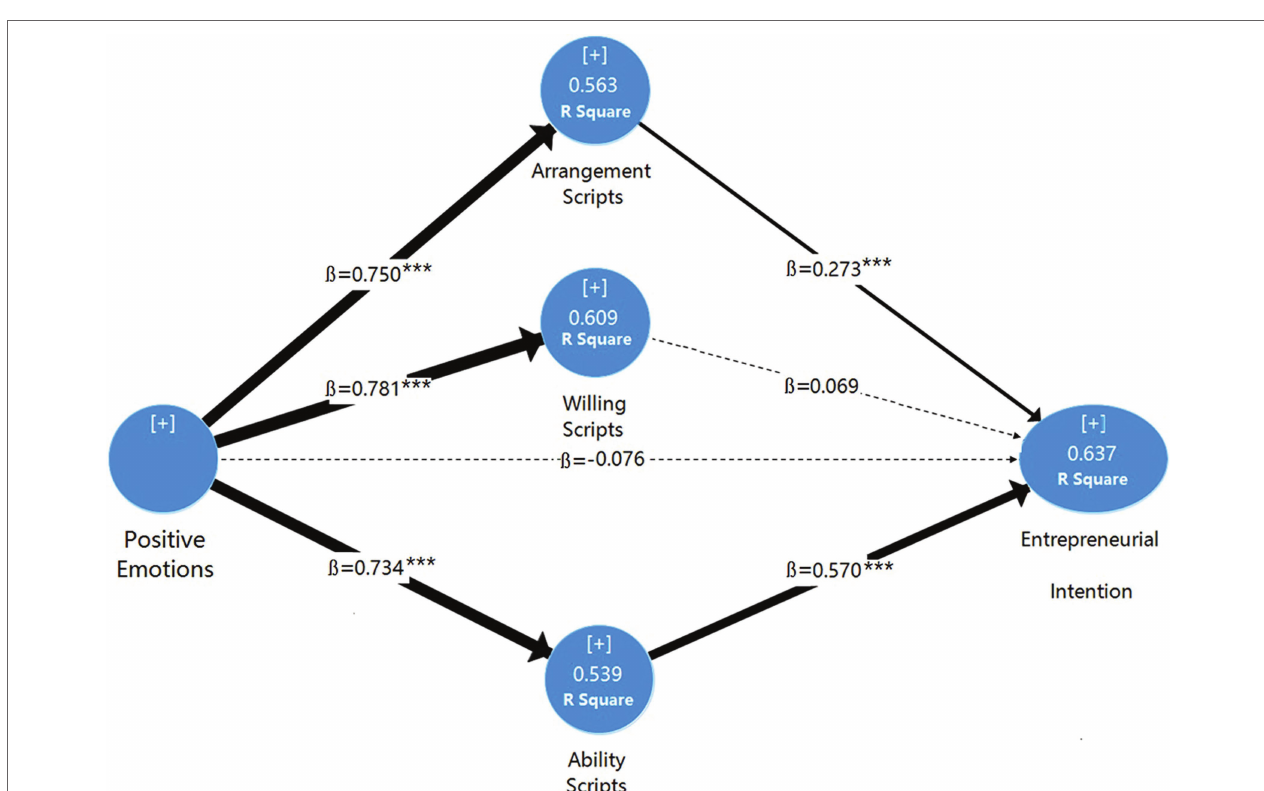
FIGURE 2 | The outcome of the structural model examination. ***p < 0.001; → , significant path; ⇢ , insignificant